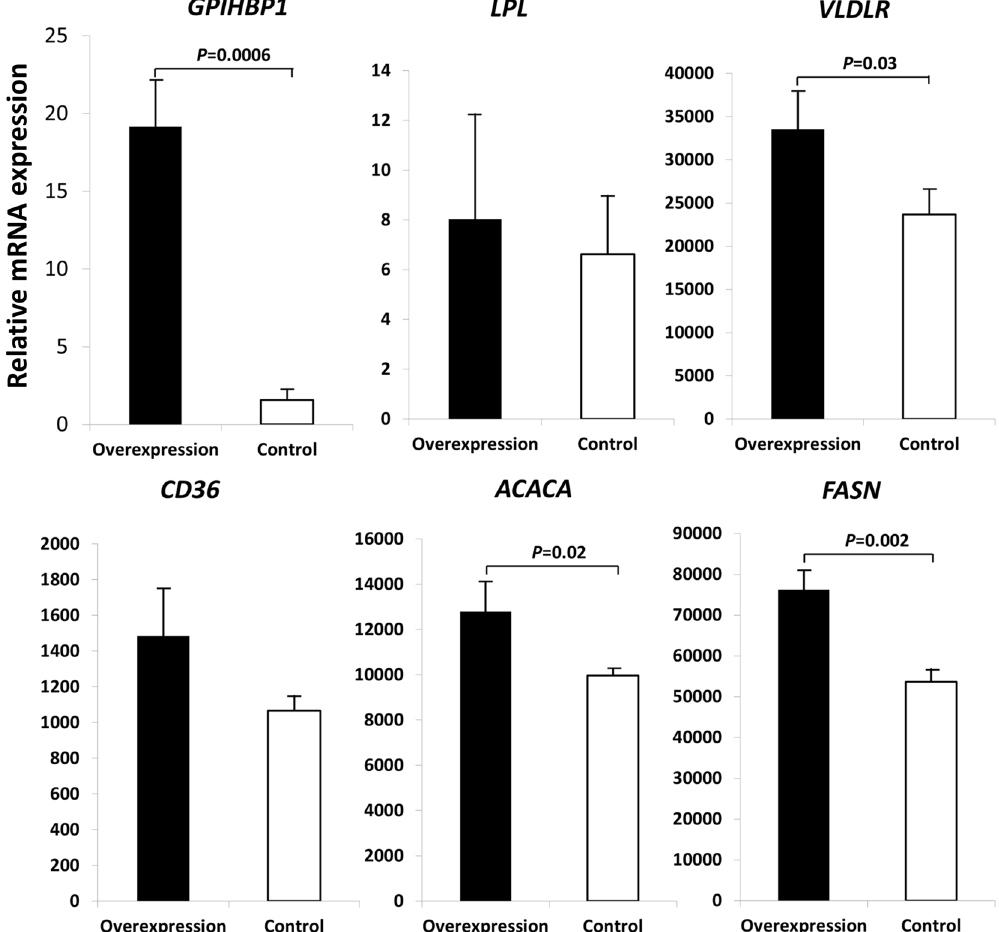
Figure 2. Expression of GPIHBP1 and five milk fat-related genes in bovine primary mammary epithelial cells that were transfected with the pcDNA3.1( + )-GPIHBP1 eukaryotic expression vector (over-expression) and with an empty vector pcDNA 3.1( + ) (control). The vertical axes represent the expression of these genes relative to the expression of the housekeeping gene GAPDH